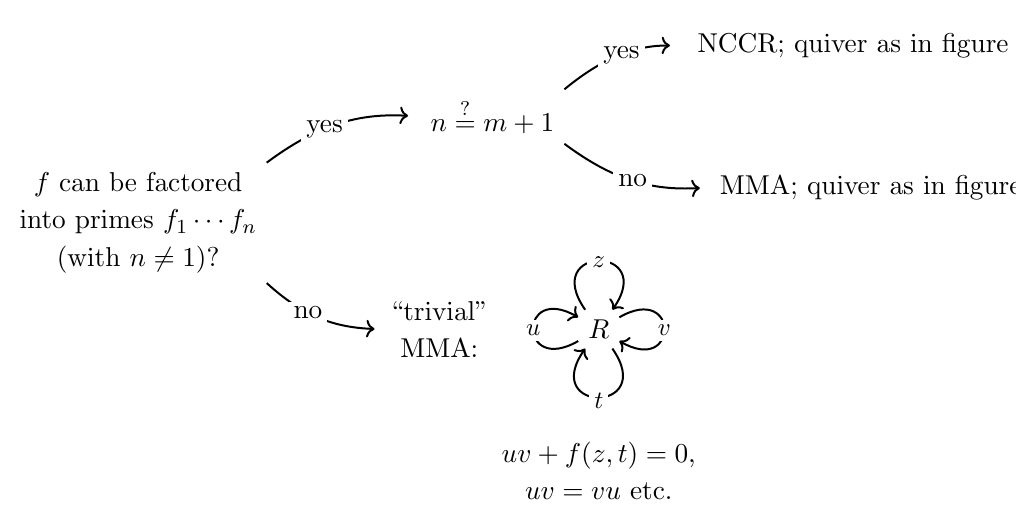
m threefold uv + f ( z; t ) =